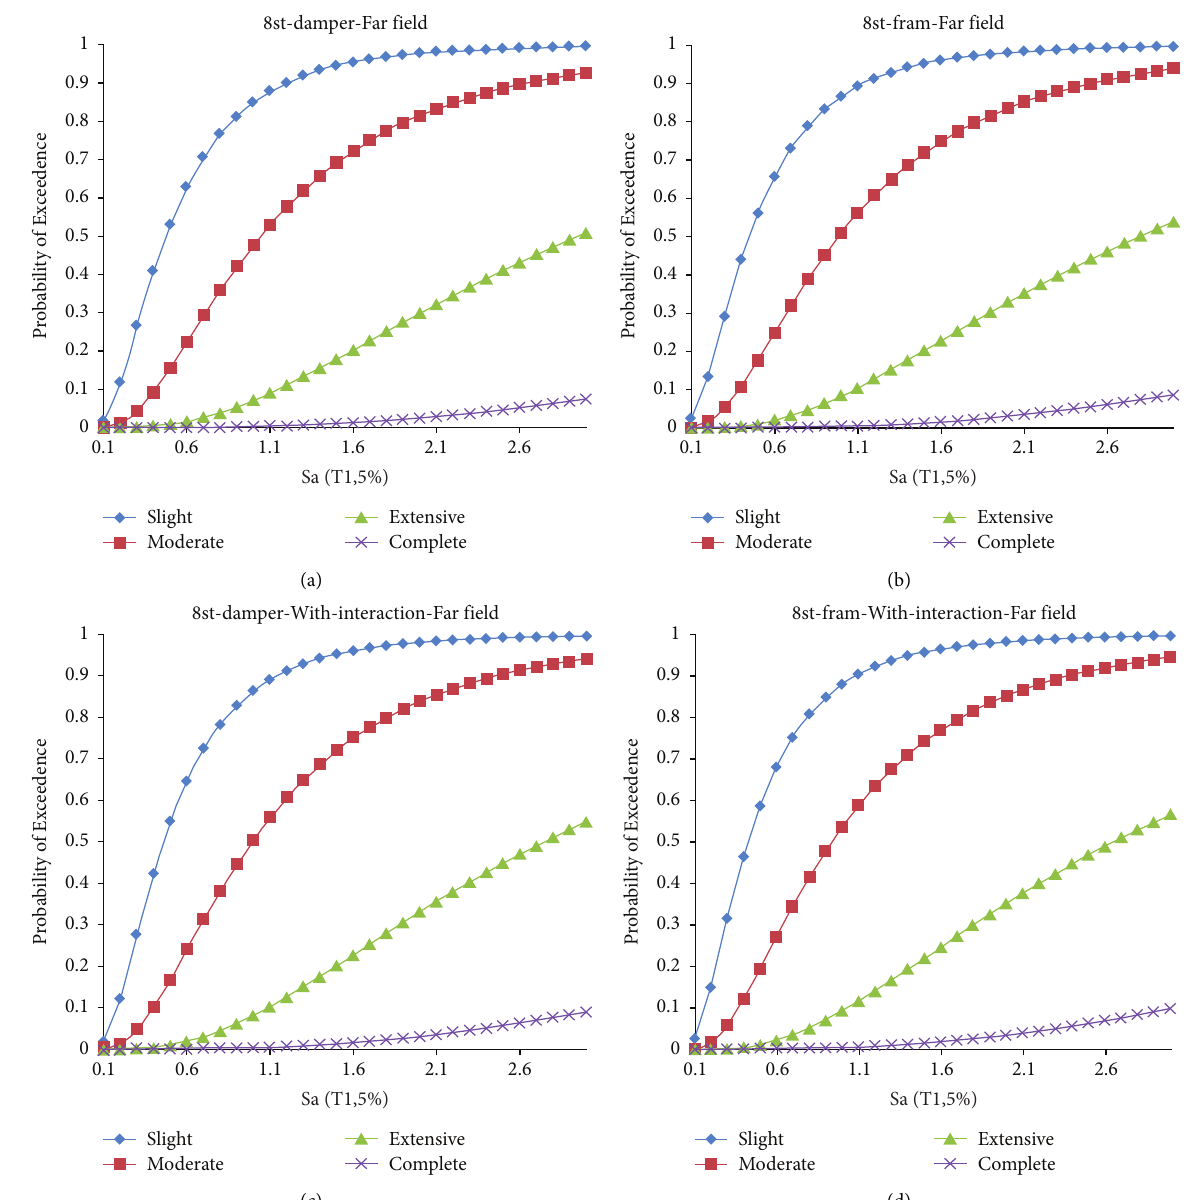
Figure 12: Fragility curves in 8-story ordinary moment resisting frame affected by far-field earthquakes. Examined cases: (a) with damper without considering SSI; (b) without damper and SSI effect; (c) with damper and considering SSI; (d) without damper but considering SSI